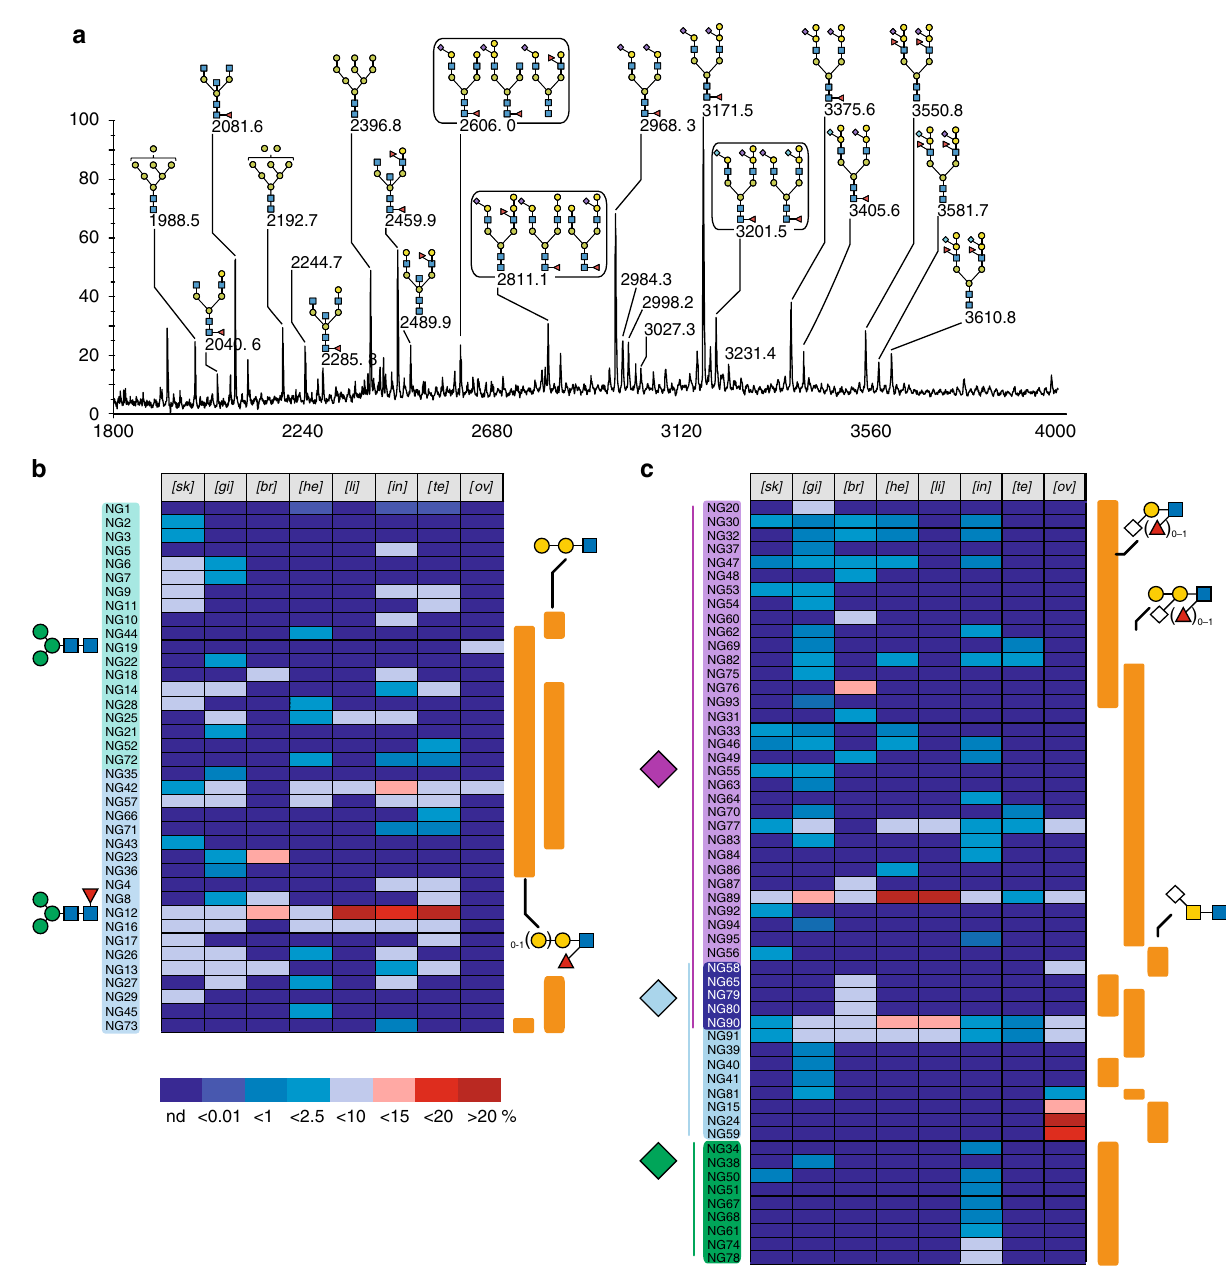
Fig. 3 N -glycome pro fi les. The chemical nature of individual glycans was established by a combination of MS/MS, GC/MS, and NMR, in comparison with previous work 28,29 and reported in Supplementary Figure 1 and Supplementary Data 1. a Representative MALDI-TOF MS spectra of permethylated NGs isolated from brain. All MS spectra are provided in Supplementary Figure 1. b Tissues-speci fi c distribution and relative quanti fi cation of neutral and ( c ) sialylated (right panel) NGs according to following glycan epitopes: core fucosylation, (Gal β 1-4) 0-1 Gal β 1-4(Fuc α 1-3)GlcNAc β , Gal β 1-4Gal β 1-4GlcNAc β for neutral and nature of substituting sialic acids (Neu5Ac, Neu5Gc, Kdn), Sia α 2-3Gal β 1-4(Fuc α 1-3) 0-1 GlcNAc β , Gal β 1-4(Sia α 2-3)Gal β 1,4(Fuc α 1-3) 0-1 GlcNAc β , and Sia α 2-6GalNAc β 1,3/4GalNAc β . All Sia residues (Neu5Ac, Neu5Gc, Kdn) linked to Gal were considered as α 2,3 linked although minor α 2,6-Gal may co-exist as described in the text. Relative quanti fi cations of individual compounds were extracted from the dataset presented in Supplementary Figure